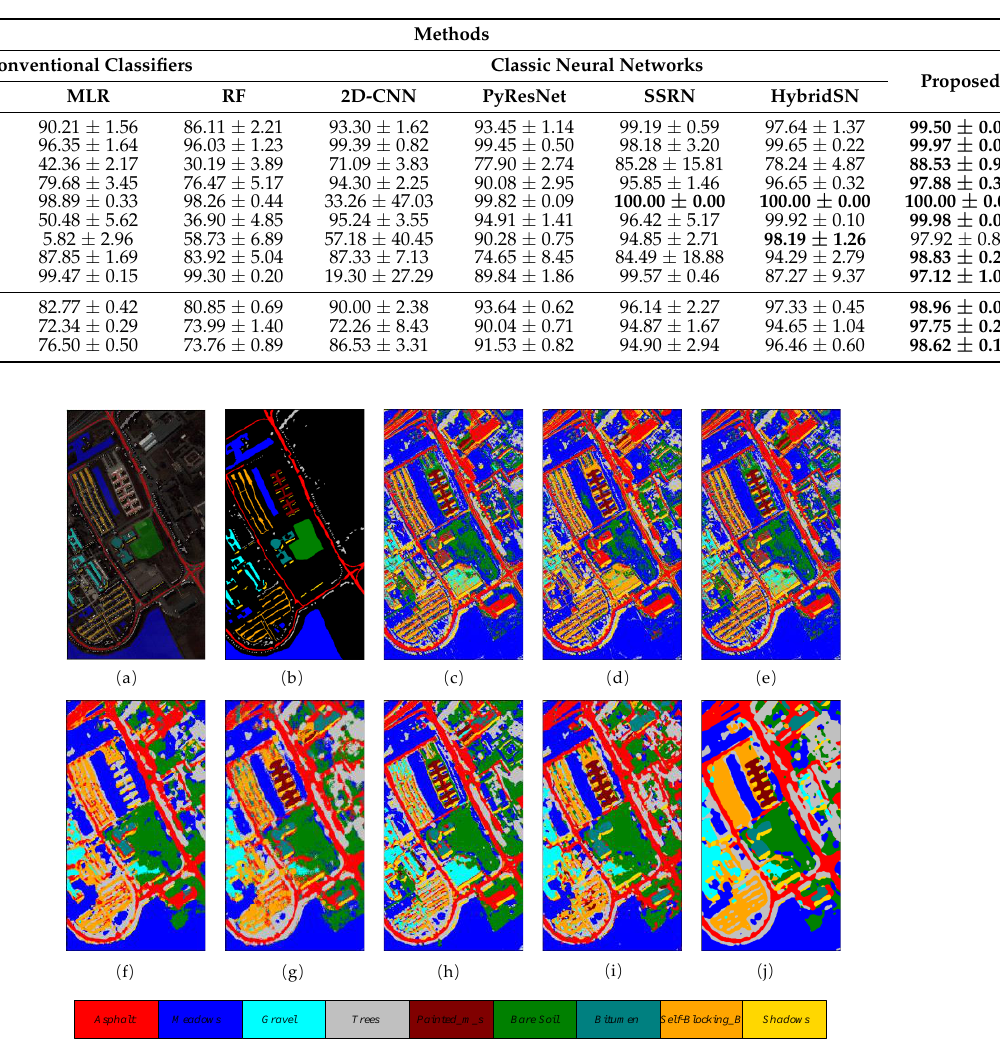
Table 5. The categorized results of different methods on the Paiva of University dataset.